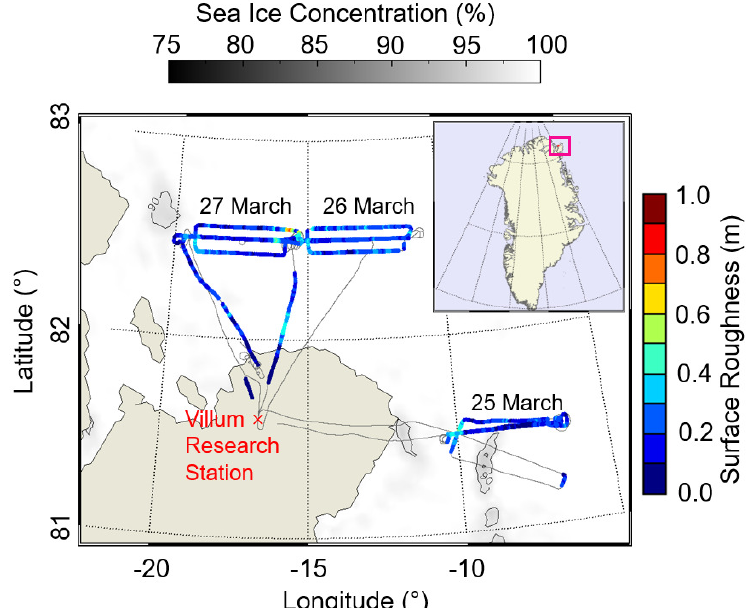
Figure 1. Color-coded sea ice roughness along the flight tracks for 25–27 March 2018 measured by the laser scanner on the Polar 5 aircraft. Dark gray line indicates flight track without laser scanner measurements. Sea ice concentration for this period is displayed in the background (basically all overflown areas had a sea ice concentration of about 100%). Insert map of Greenland shows location of measurement area (red